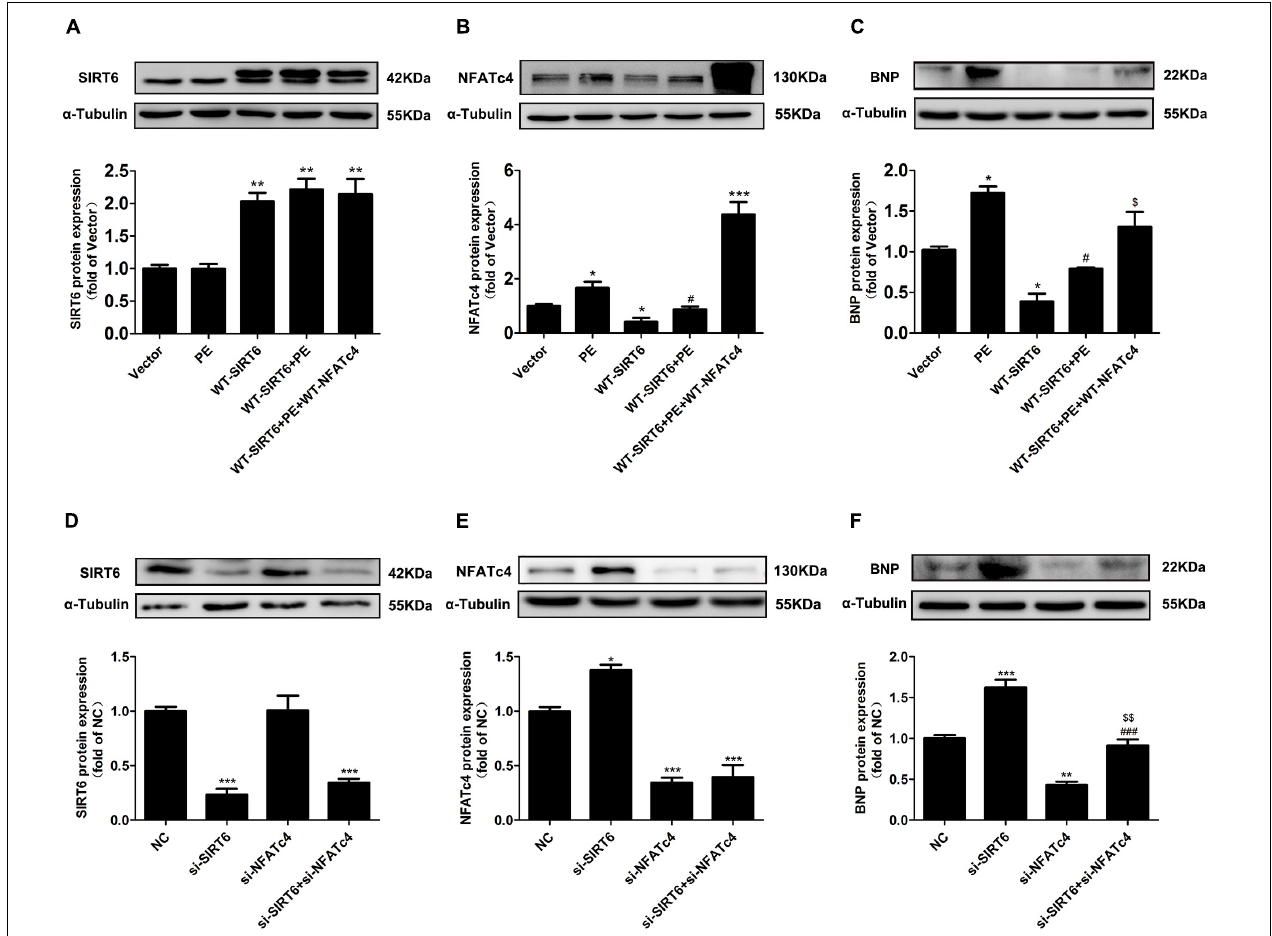
FIGURE 7 | NFATc4 participated in the anti-hypertrophic effect of SIRT6. (A–C) Western blot analysis of the protein expression of SIRT6, NFATc4, and BNP in NRCMs transfected with or without WT-NFATc4, WT-SIRT6, and treated with 100 µ M PE for 12 h. (D–F) The protein expression of SIRT6, NFATc4, and BNP in NRCMs transfected with siRNAs of SIRT6, NFATc4, or negative control (NC) for 48 h. The data were presented as mean ± SEM. ∗ P < 0.05, ∗∗ P < 0.01, ∗∗∗ P < 0.001 vs. Vector or NC. # P < 0.05, ### P < 0.001 vs. PE or si-SIRT6. $ P < 0.05, $$ P < 0.01, vs. WT-SIRT6 + PE or si-NFATc4. n =